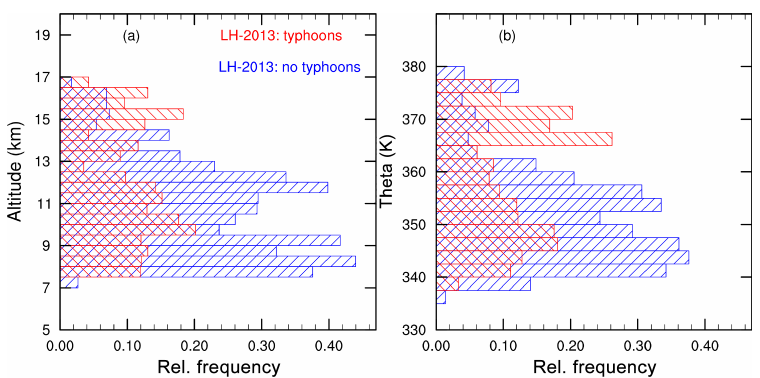
Figure 9. The relative frequency distribution of the target air masses originating from the boundary layer with the influence of typhoons (red) and without the influence of typhoons (blue) versus (a) altitude and (b) potential temperature in August 2013.